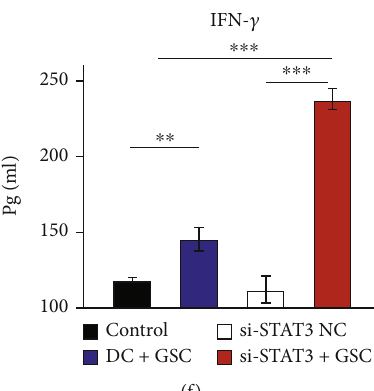
Figure 5: Isolation, di ff erentiation, and cytokine secretion of T-lymphocytes. (a) The image of T cells (100x) and the expression of T cell marker CD3-FITC before and after magnetic-activated cell sorting (MACS). Numbers indicate percentages of positive cells. (b and d) CD8+ T-cell generation in the STAT3 de fi ciency DC group was signi fi cantly increased. (c and e). Foxp3+ CD4+ T-cell generation in the STAT3 de fi ciency DC group had evaluated less than other groups. (f) ELISA results showed that secretion of INF- γ by T-lymphocytes stimulated with STAT3-null DCs pulsed with GSCs was upregulated compared with that by T-lymphocytes stimulated with DCs transfected with GSCs (1.63-fold). Bars represent the mean ± SD . Comparison with the T-lymphocytes group stimulated with DCs loaded GSCs. ∗ p < 0 : 05 , ∗∗ p < 0 : 01 , ∗∗∗ p < 0 : 001